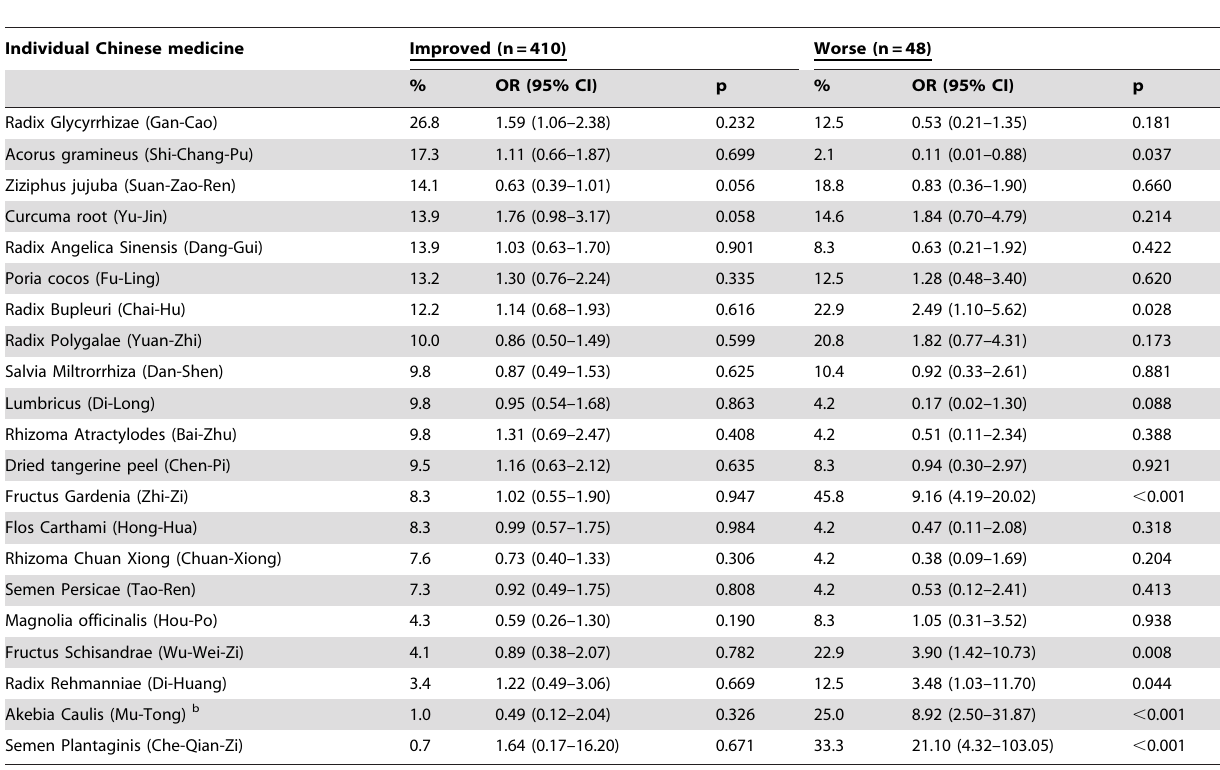
Table 5. Multivariate associations of clinical outcomes with individual CMs in concomitant use with antipsychotics in schizophrenic patients. a